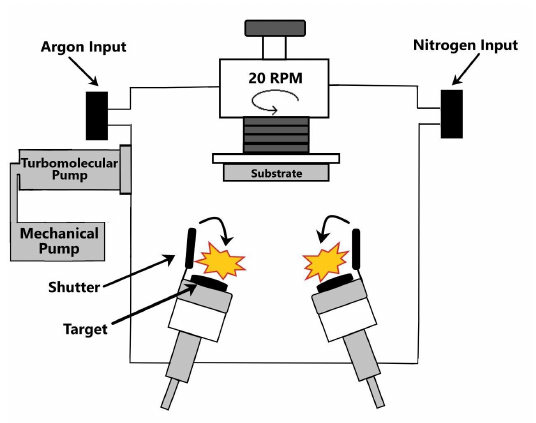
Figure 1. Schematic representation of deposition chamber.